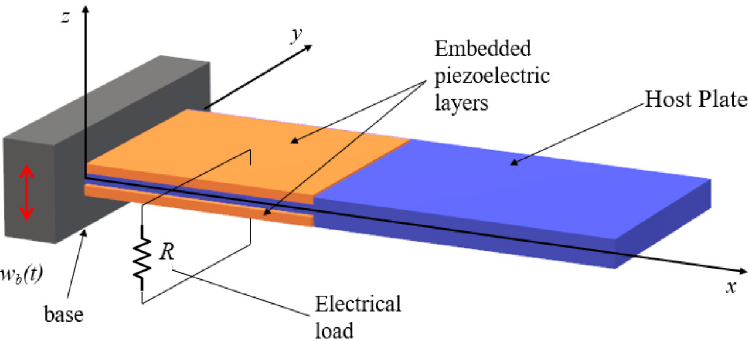
Figure 1. A cantilever bimorph PEH harvester with a load resistance in series connection.